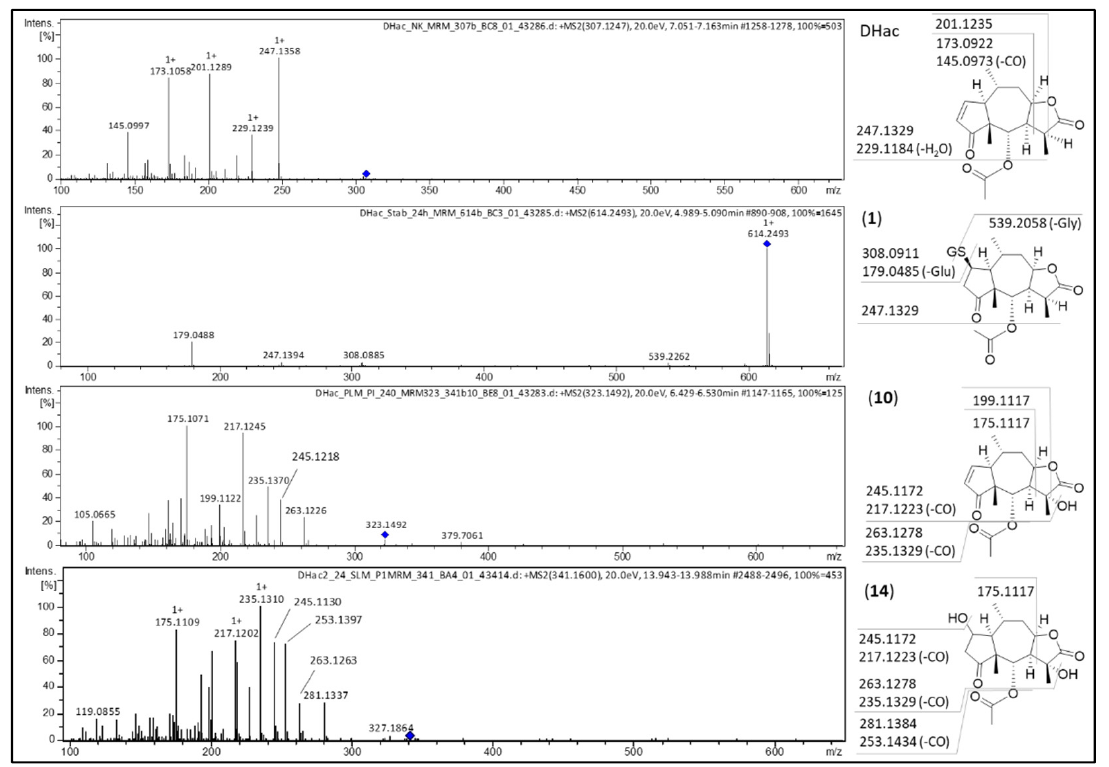
Figure 3. MS/MS spectra of DHac and its most abundant metabolites DHac-GSH ( 1 ), DHac-OH ( 10 ) and DHac-H 2 O-OH ( 14 ) with postulated fragmentation sites. At the structural diagrams the calculated m / z values are given.